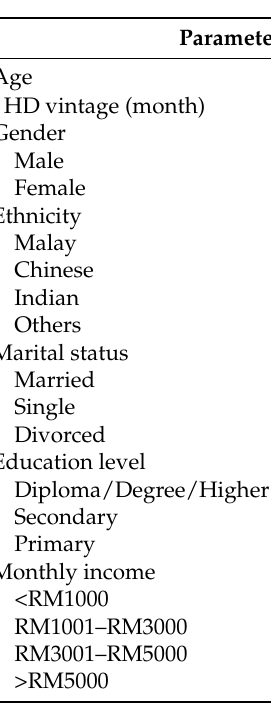
Table 1. Patient socio-demographics ( n =